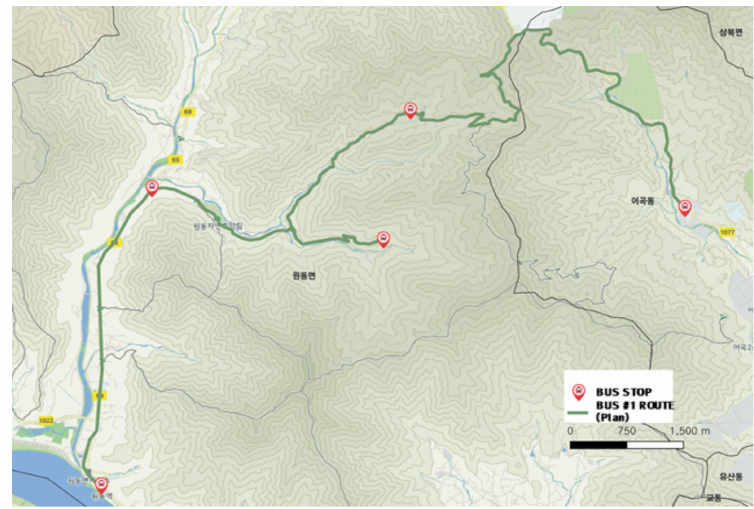
Figure 9. City-type bus No. 1